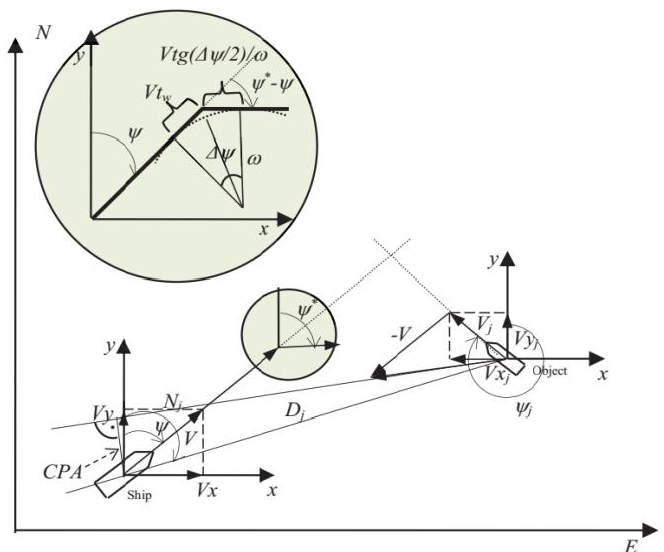
Figure 2. Illustration of the situation in which the ship passes near the j -th target. DCPA(CPA) — the closest point of approach; D j — distance between ship and j -target; V — ship speed; V j — j-th ob-